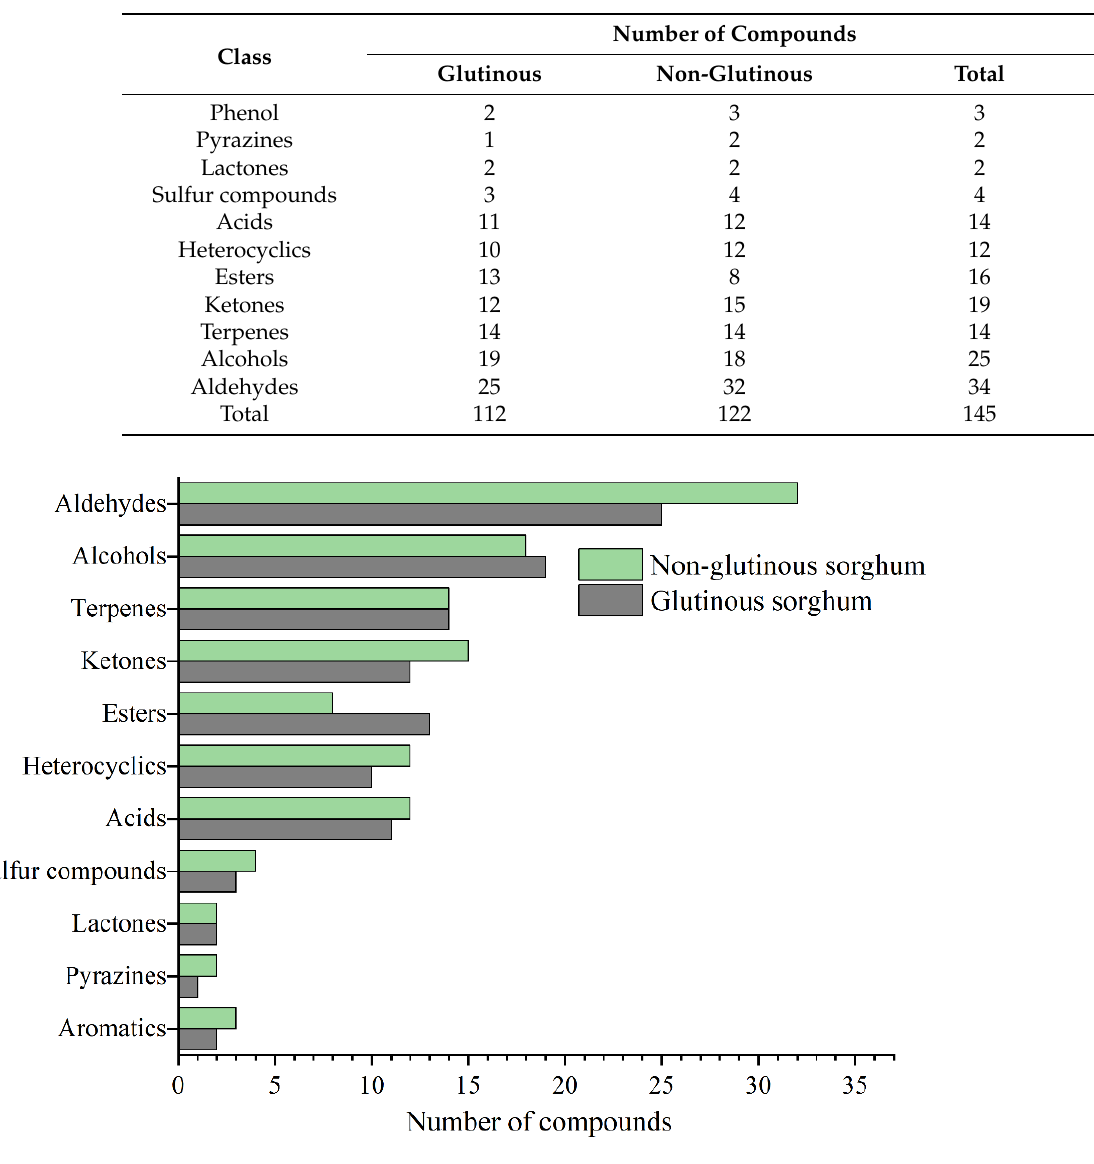
Figure 3. Comparison of identification compounds in cooked glutinous and non-glutinous sorghum obtained by HS-SPME-GC×GC-TOFMS. GC ×